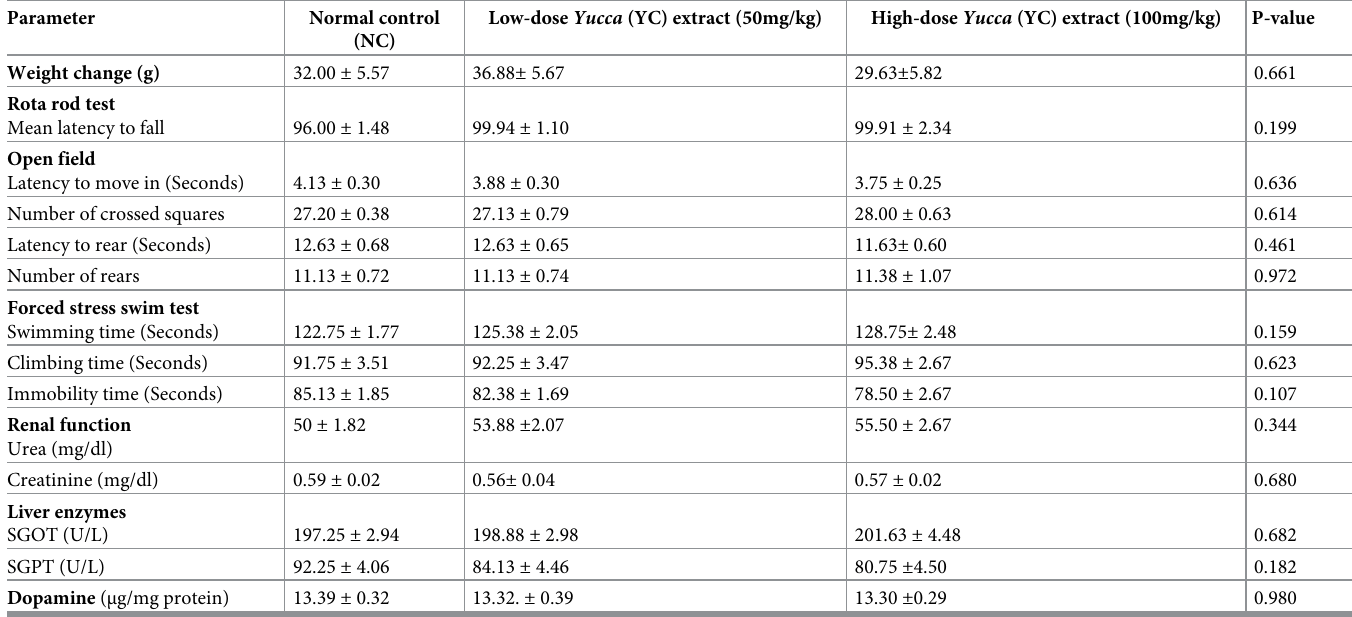
Table 2. Effect of different doses of Yucca extract (YC) on weight, neurobehavioral and locomotor tests, renal function, liver enzymes, and